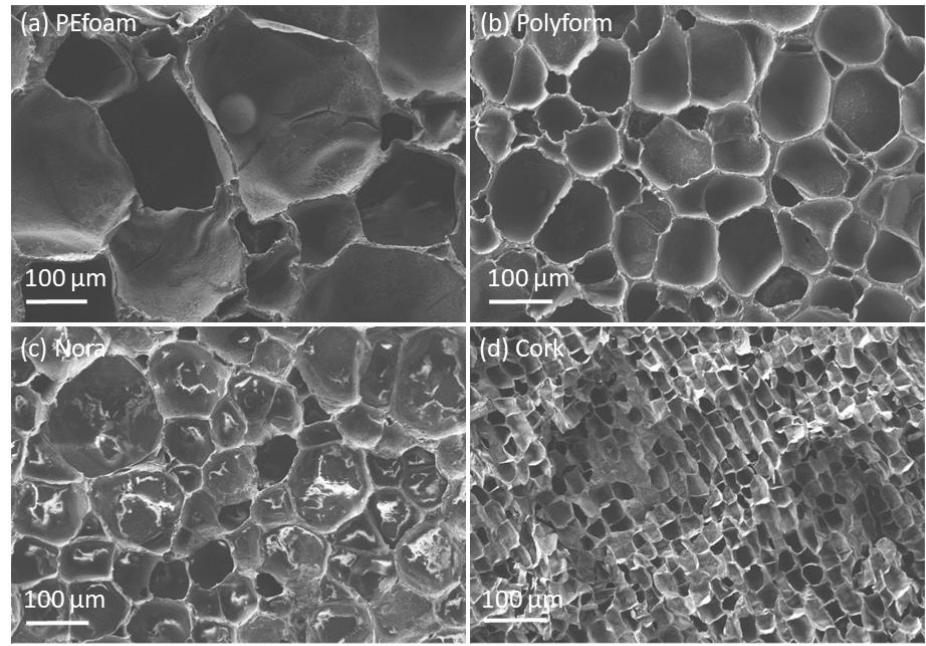
Figure 2. Field-emission scanning electron microscopy (FE-SEM) micrographs of cellular structure of foamed samples: ( a ) PEfoam, ( b ) Polyform, ( c ) Nora and ( d ) cork.